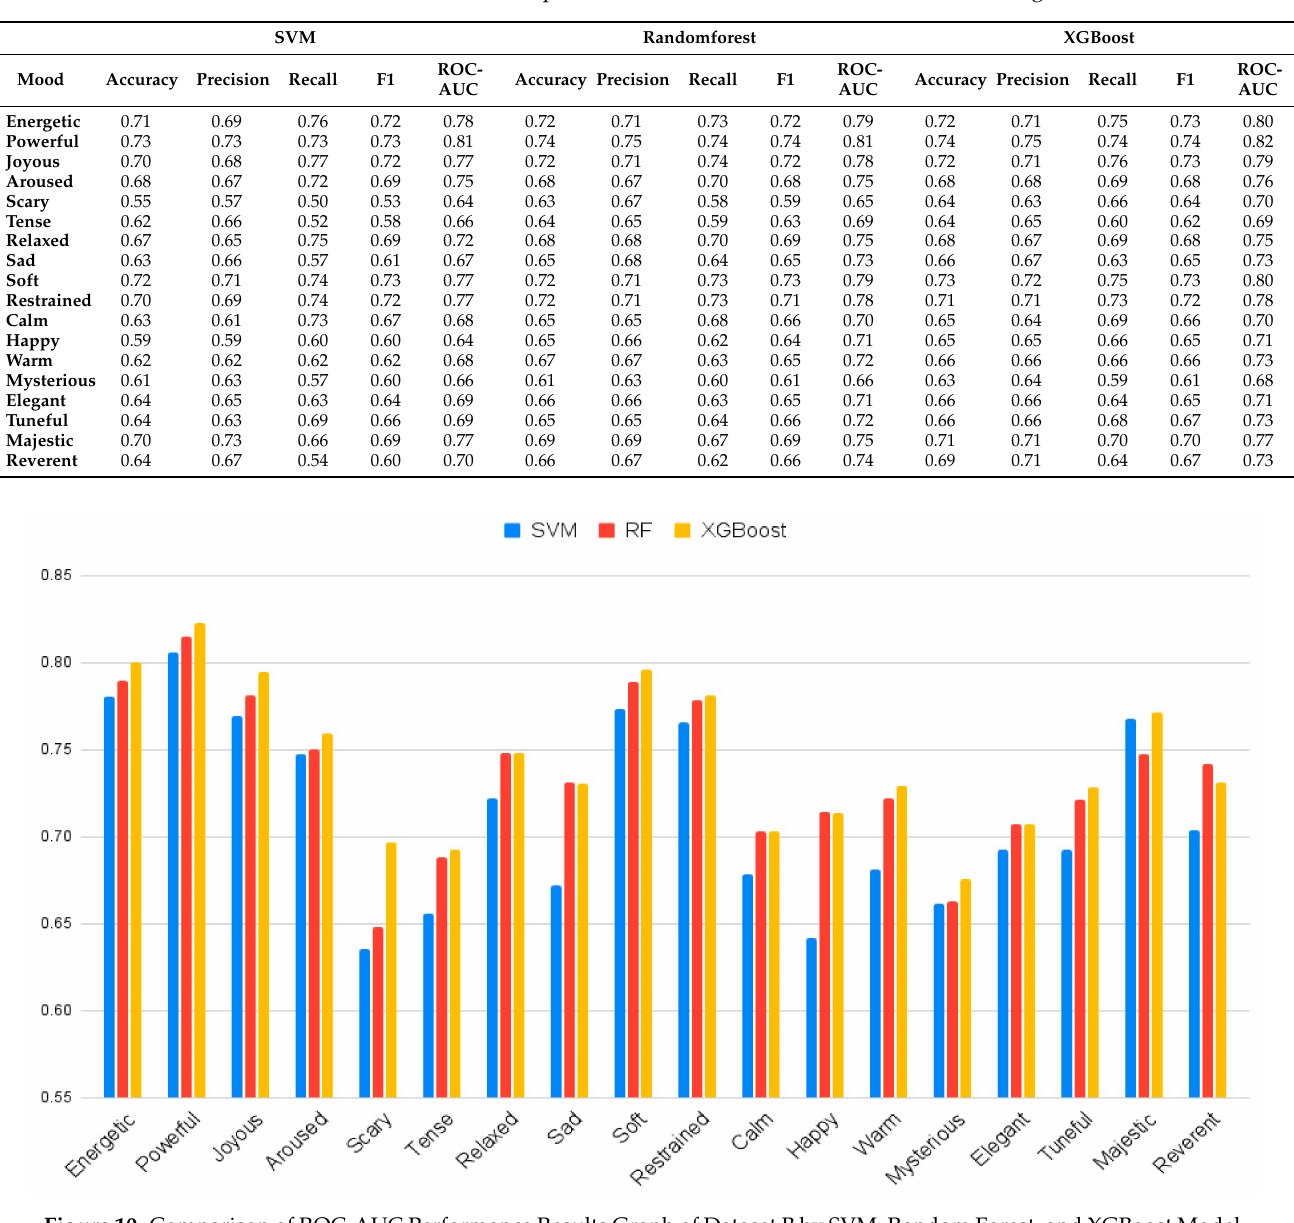
Table 3. Cross Validation Result Comparison of SVM, Random Forest, and XGBoost Algorithm.